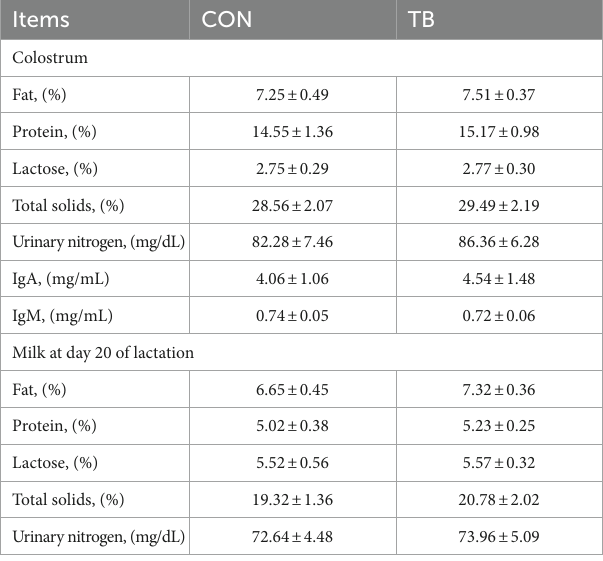
TABLE 2 Effects of tributyrin on feed intake and backfat thickness during lactation in sows.